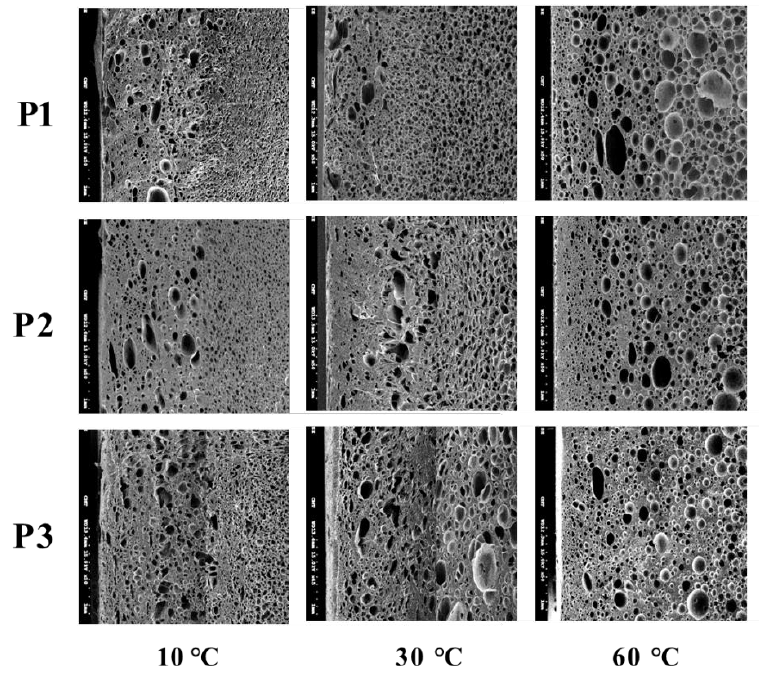
Figure 9. The effect of DMTC corresponding to different cooling rates on foaming morphology.